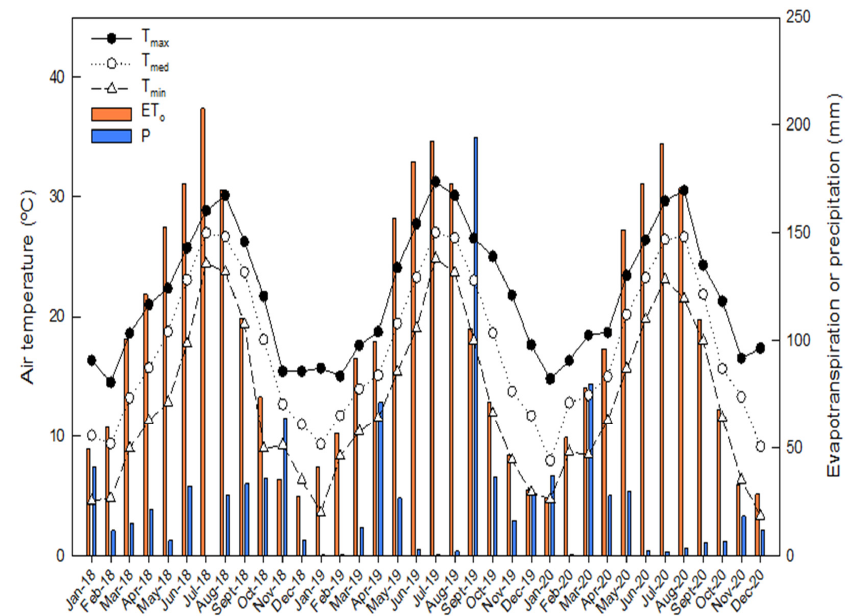
Figure 1. Monthly average maximum, minimum and mean air temperature (T max , T min and T mean ), accumulated precipitation (P) and reference evapotranspiration (ET o ) recorded from Cieza meteorological station, for the period 2018–2020.